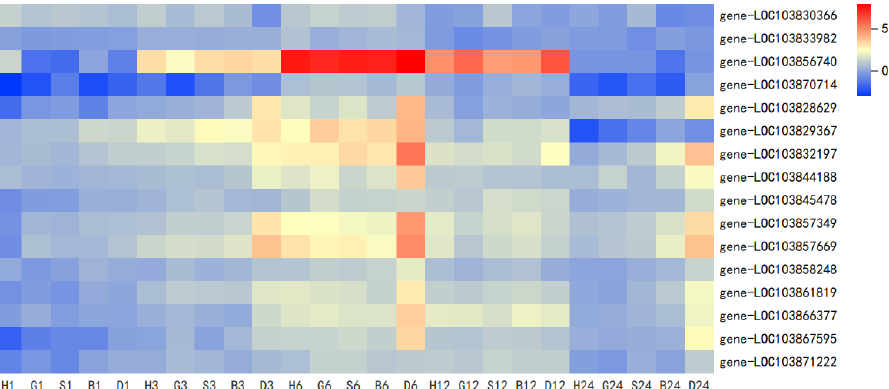
Figure 3. DEGs in stress response to spraying treatments at 1, 3, 6, 12, and 24 h. Heat map represents the value of DEGs as L2FC relative to CK (0 h) (H, H 2 O treatment; G, GSH treatment; S, GSSG treat- ment; B, BSO treatment; D, DTT